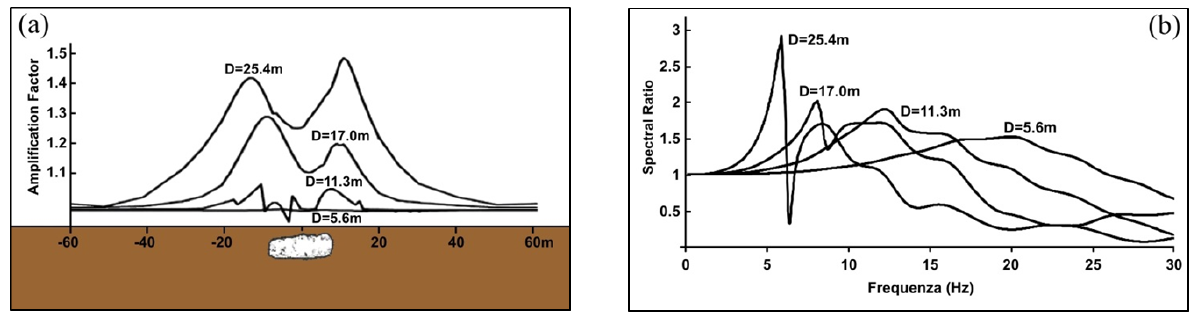
Figure 1: Amplification factor (a) and spectral ratio (b) values above an underground cave inside a homogeneous and isotropic subsoil crossed by V waves, based on the parametric variation of the cave diameter (from [7] s